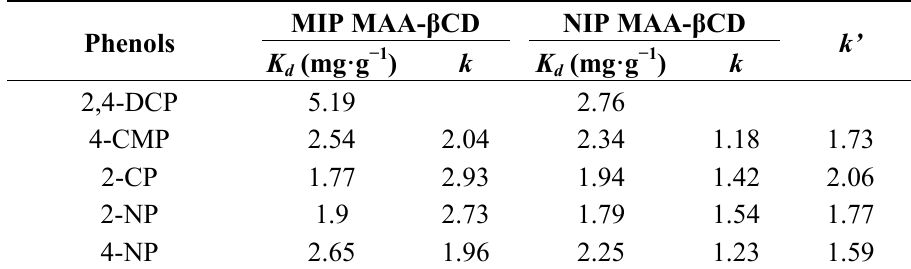
Table 4. Selectivity parameters of the MIP MAA-βCD and NIP